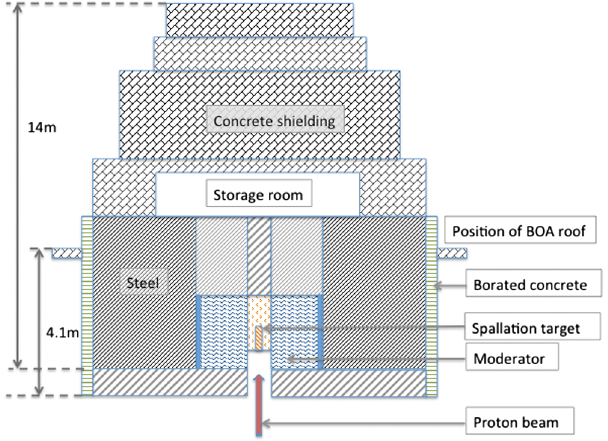
FIG. 1. Schematic drawing of SINQ model in G